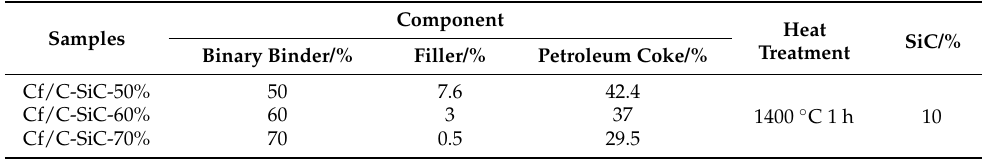
Figure 1. The schematic of the fabrication process of the Cf/C-SiC composites. Table 1. Proportion of components in slurry.